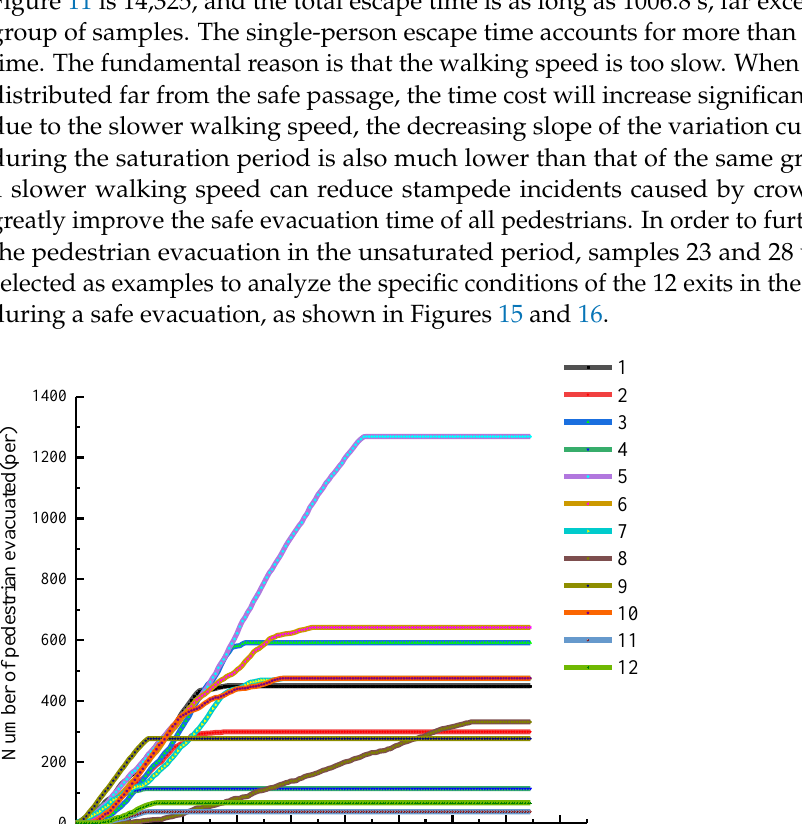
Figure 14. ( a ) Density of export pedestrians during saturation period; ( b ) Density of export pedestrians in unsaturated period.